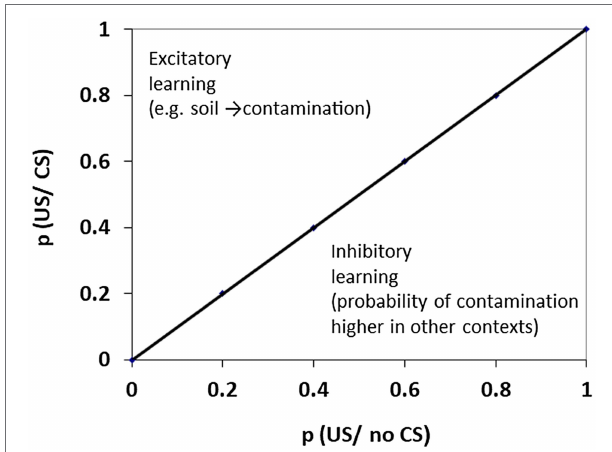
FIGURE 1 | Positive prediction error is seen when the probability ( p ) of the unconditioned stimulus (US) is increased on presentation of the CS+ and generates excitatory conditioning. Negative prediction error is seen when the probability of the US is decreased on presentation of the CS- and generates inhibitory conditioning. When p (US/CS) = p (US/no CS) along the diagonal trend line there can be no new learning. In the example shown, soil provides excitatory stimuli that generate fear of contamination. However, the stimuli provided by exposure to soil could become inhibitory (safety) signals if the probability of contamination were perceived as higher in contexts where soil- related cues are absent (in which case gardening might feel like a safer exercise than swimming at the public baths). Positive and negative prediction error are depicted as Pavlovian phenomena arising from specified and predictable relationships between (CS and US) environmental events. In addition, stimuli generated by instrumental responses (both external